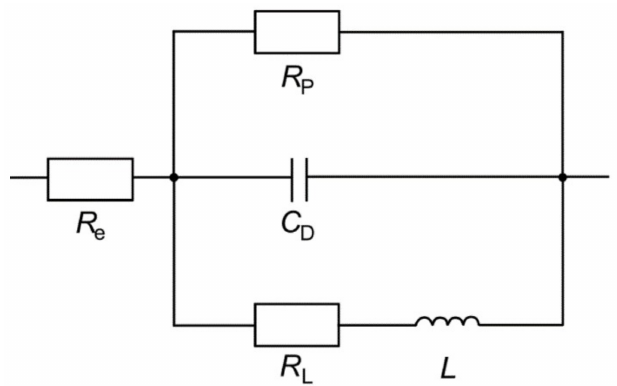
Figure 1. Equivalent circuit used for fitting the EIS results.